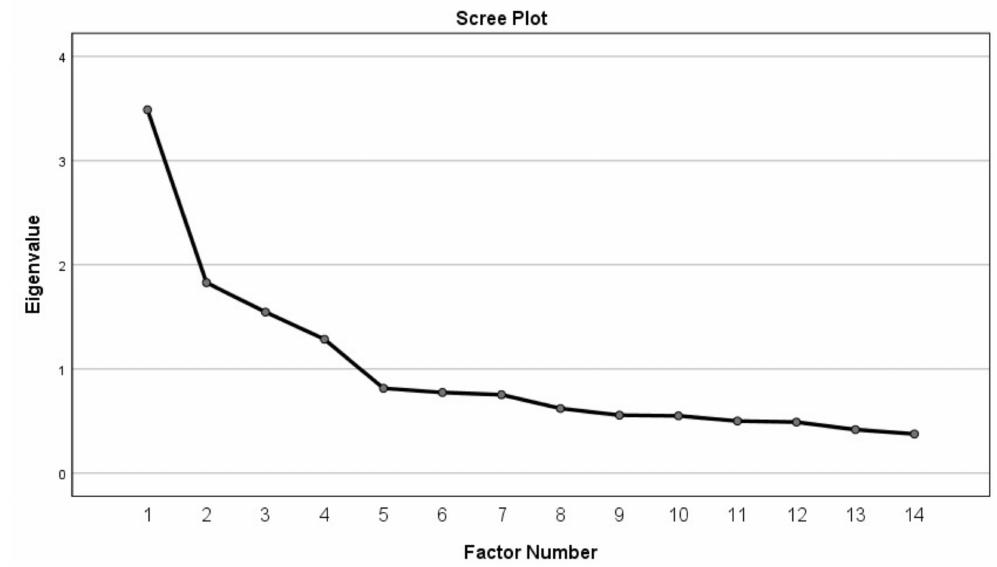
Figure 1. Scree Plot of Eigenvalues.